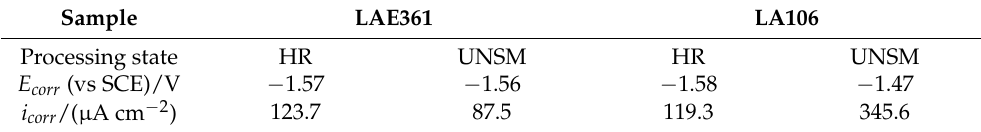
Figure 12. Potentiodynamic polarization curves of LAE361 Mg-Li alloy ( a ) and LA106 Mg-Li alloy ( b ) before and after the UNSM treatment in 3.5 wt.% NaCl solution at RT. Table 3. E corr and i corr of LAE361 and LA106 Mg-Li alloys before and after the UNSM treatment.